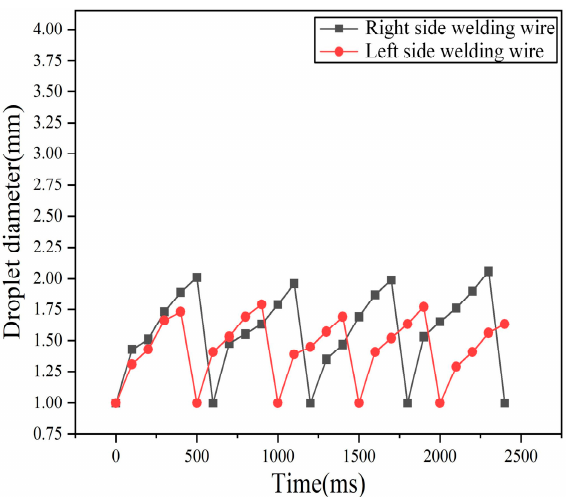
Figure 8. Changes in droplet size in the mode of “bridge transfer + bridge transfer”.